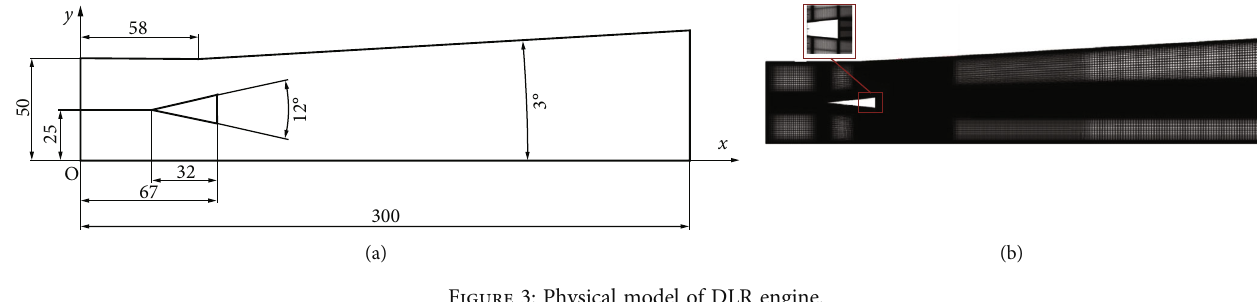
Figure 3: Physical model of DLR engine. Table 3: Boundary